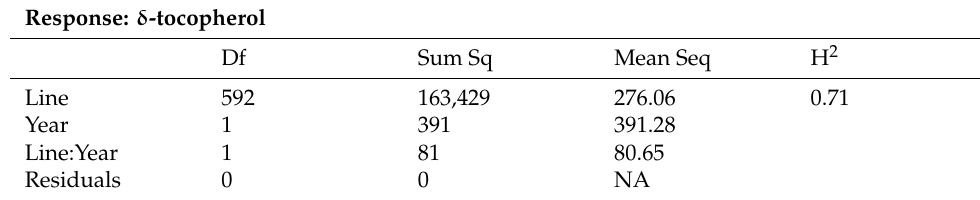
Figure 1. The distribution of seed tocopherol contents ( µ g/g of seed weight) in the FxW82 RIL population. The seed α -Tocopherol ( α -Toc), δ -Tocopherol ( δ -Toc), ( γ + β )-Tocopherol (( γ + β )-Toc), and Total-Tocopherols (T-Toc) contents were tested in the RILs harvested in Carbondale, IL 2017 and 2020, respectively. Table 2. The broad sense heritability (h 2 ) of tocopherol traits ( δ -tocopherol, ( γ + β )-tocopherol, α - tocopherol, and total-tocopherol) from the seeds harvested at Carbondale, IL in 2017 and